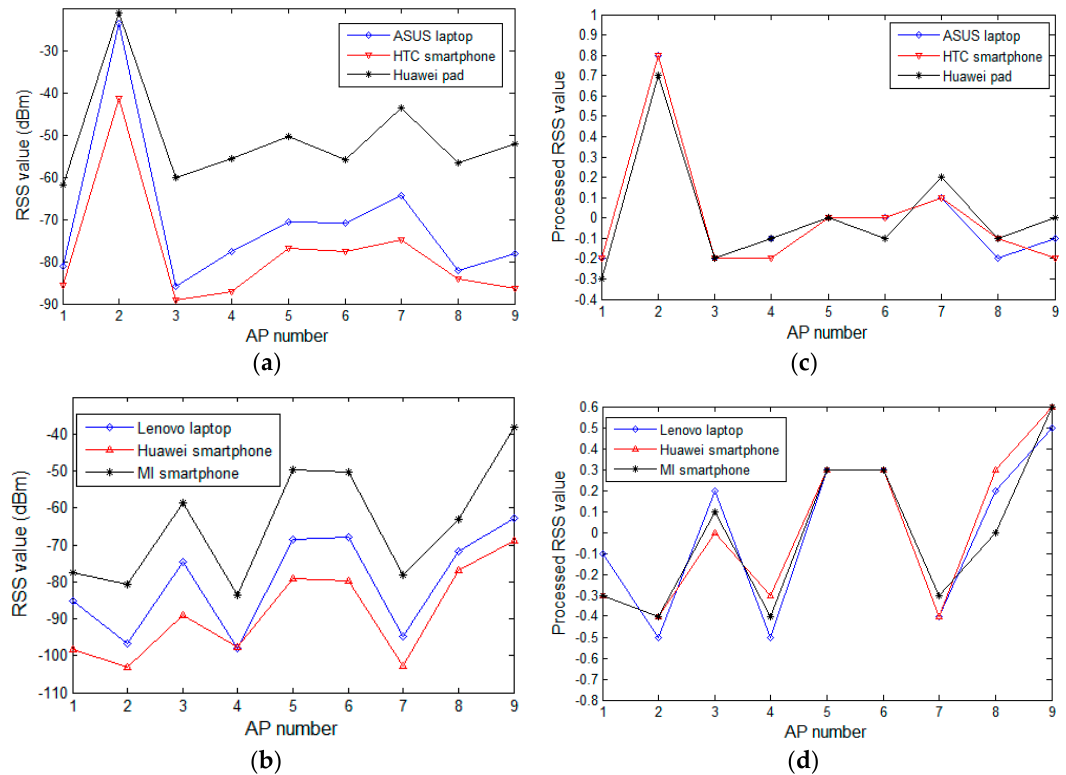
Figure 3. RSS values change versus AP numbers: ( a ) the raw RSS values of the surrounding change in APs versus AP numbers at reference location three; ( b ) the raw RSS values of the change in surrounding APs versus AP numbers at reference location five; ( c ) the processing result of ( a ); and ( d ) the processing result of ( b ).